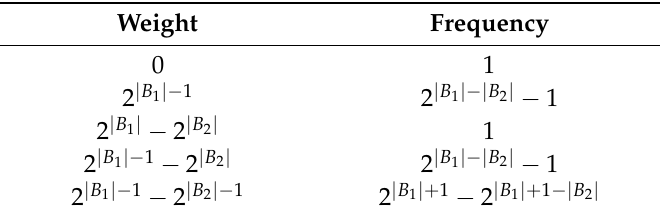
Table 4. Weight distribution of the code in Theorem 1